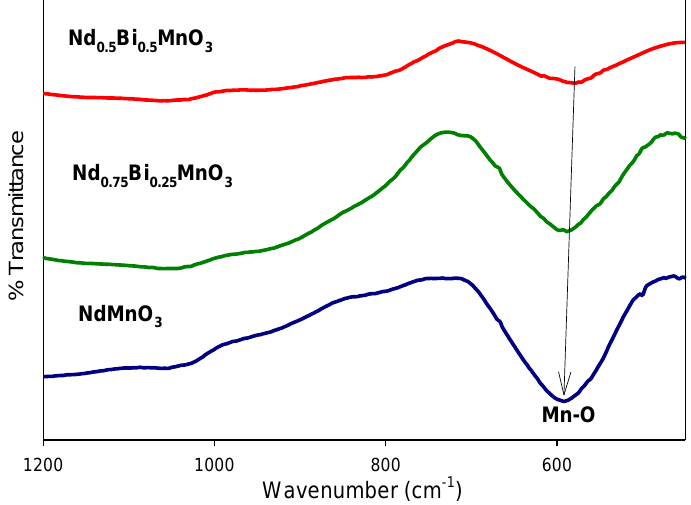
Figure 4. Fourier transform infrared spectroscopy (FTIR) spectra of Nd 1 − x Bi x MnO 3 (x = 0, 0.25 and 0.50).